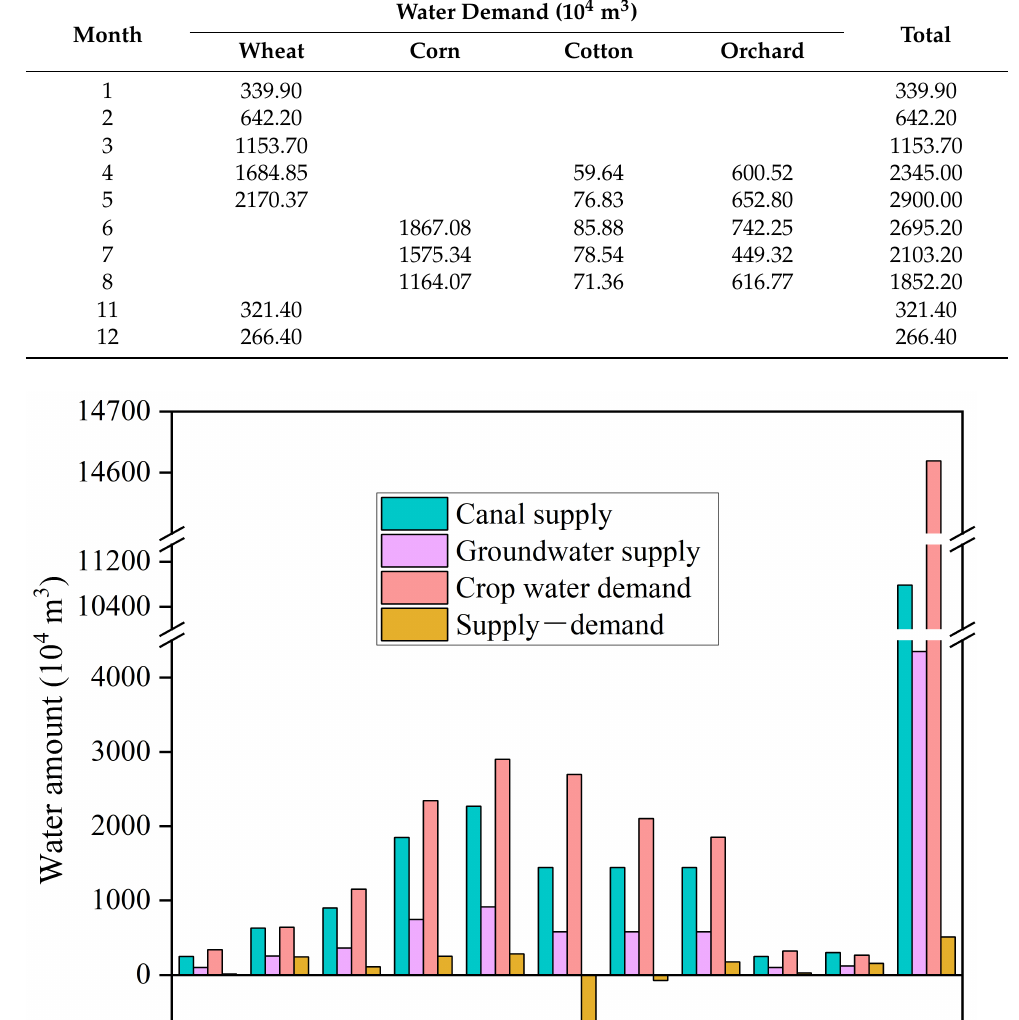
Table 2. Monthly water demand during the irrigation period.